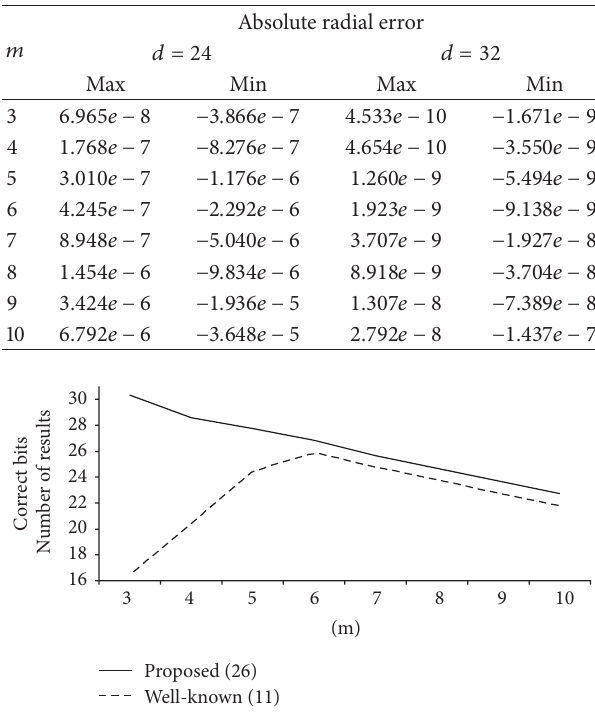
Table 4: Maximum values of the absolute radial error ( 𝑅 = 2 2𝑚+3 ) for proposed Algorithm (26).